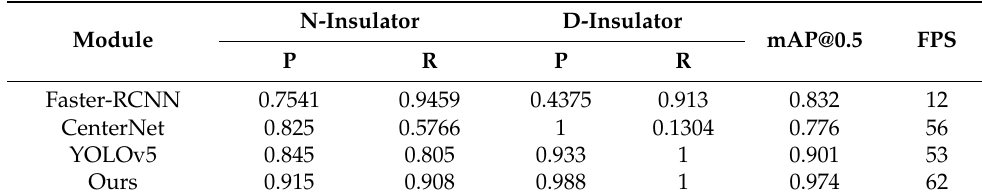
Table 3. Performance comparison of different models.